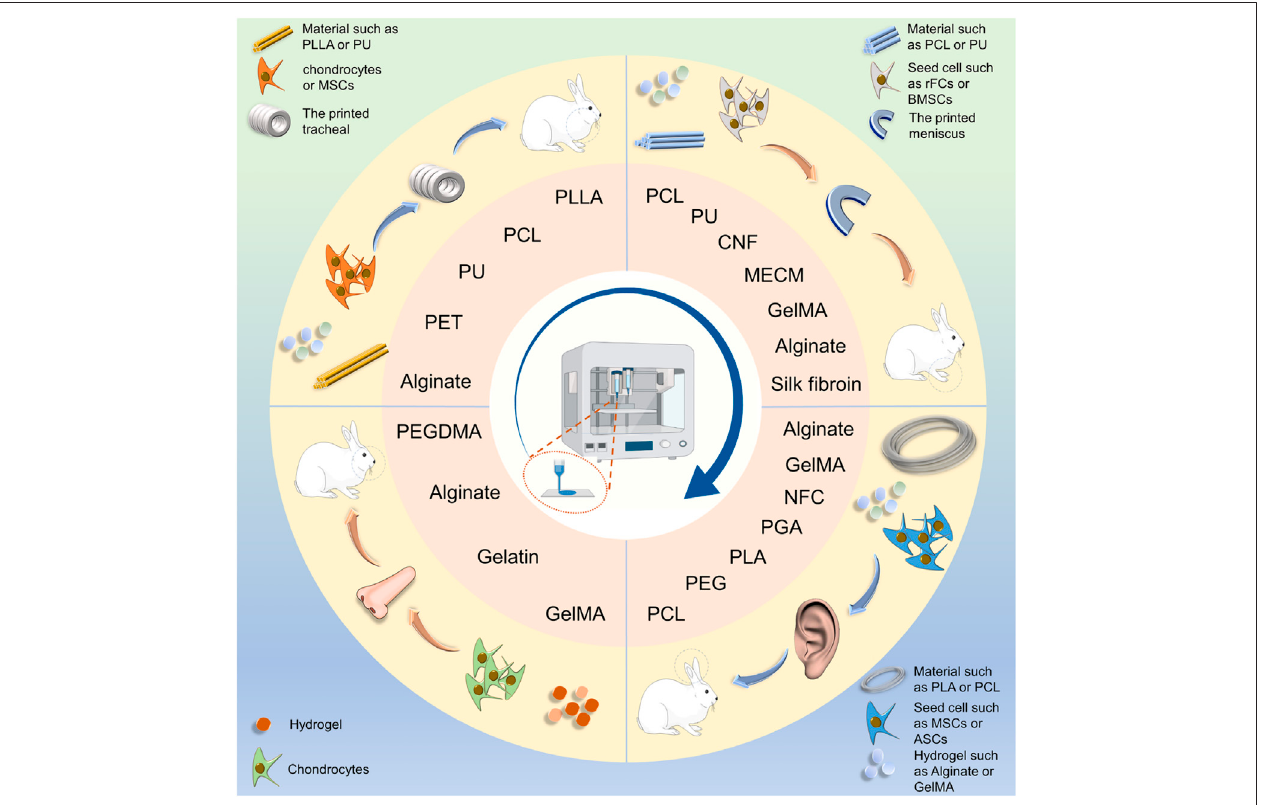
SCHEME 2 | Schematic illustration of scaffold fabrication for cartilage engineering of the auricle, nasal cartilage, trachea, and meniscus. Polymers and hydrogel were made into irregularly shaped cartilage scaffolds using 3D printing technology. PLLA, poly(L-lactic acid); PCL, Poly( ε -caprolactone); PU: Polyurethane; PEG, polyethylene glycol; PEGDMA, polyethylene glycol dimeth-acrylate; PGA, polyglycolic acid; NFC, nano fi ber cellulose; MECM, meniscus extracellular